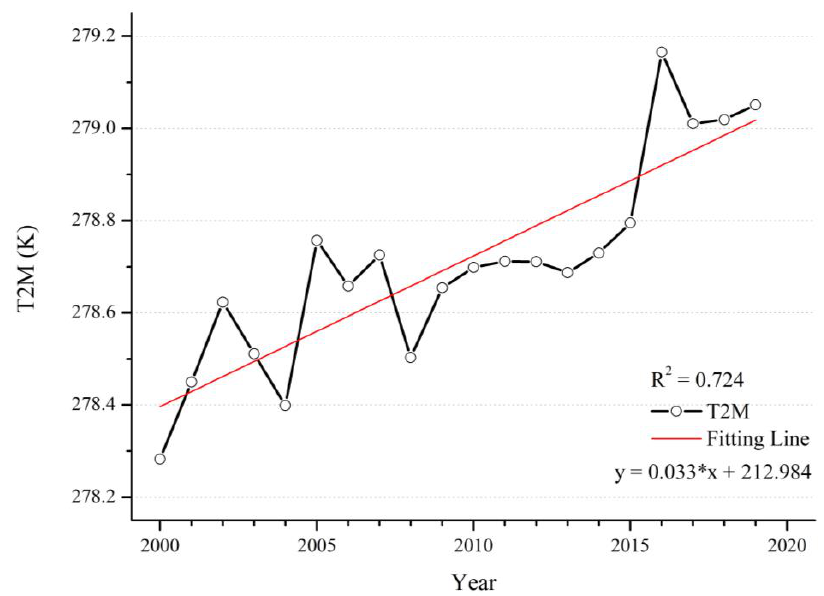
Figure 8. Time series of the annual mean temperature at 2 m high from 2000 to 2019.